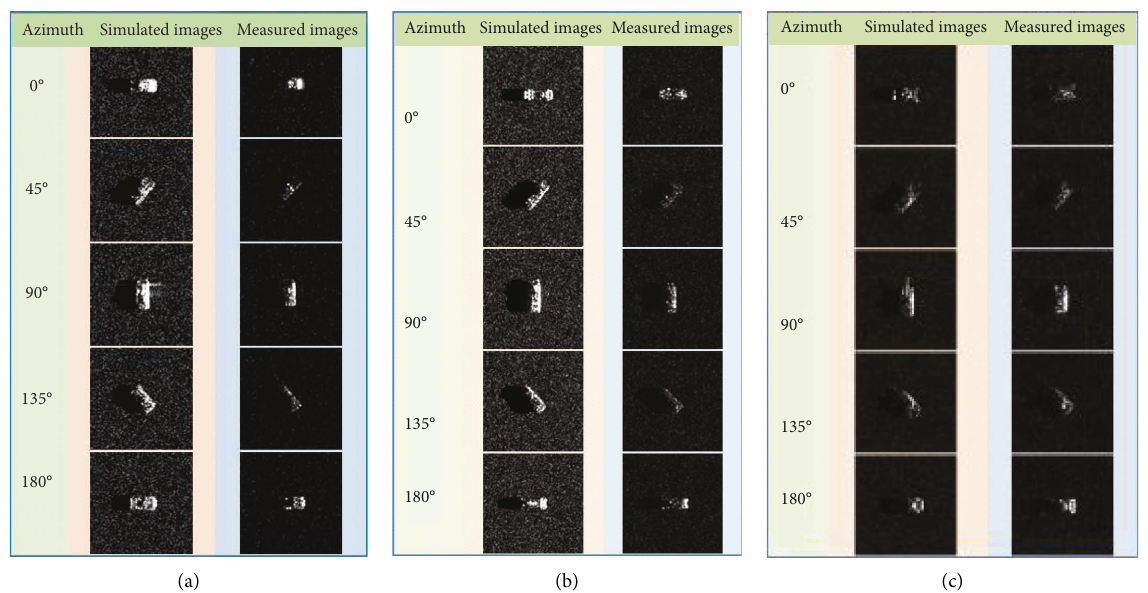
Figure 3: SAR simulation images of vehicles on grassland and MSTAR measured SAR images. (a) BMP2; (b) BTR70; (c)